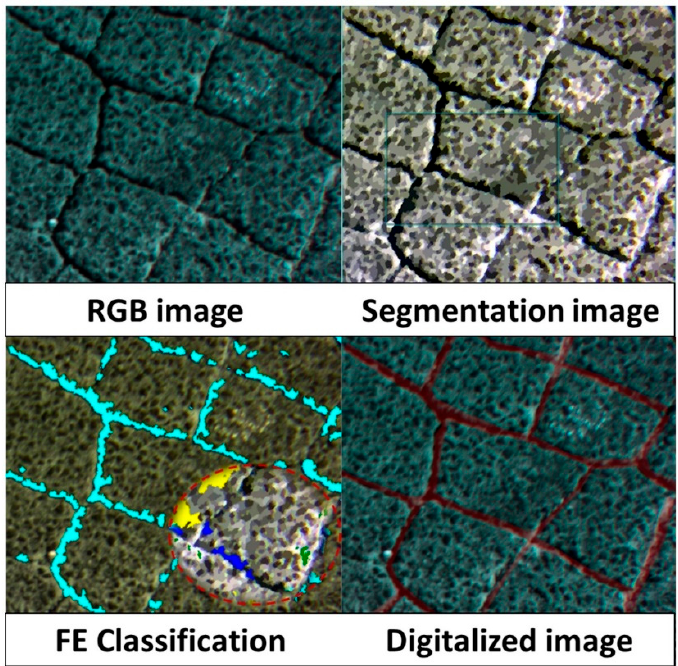
Figure 5. The Image Distress Quantity extracted by means of digitalization and FE classification (known features in red dotted circle: yellow-bitumen; green-aggregates; cyan/blue-cracks).